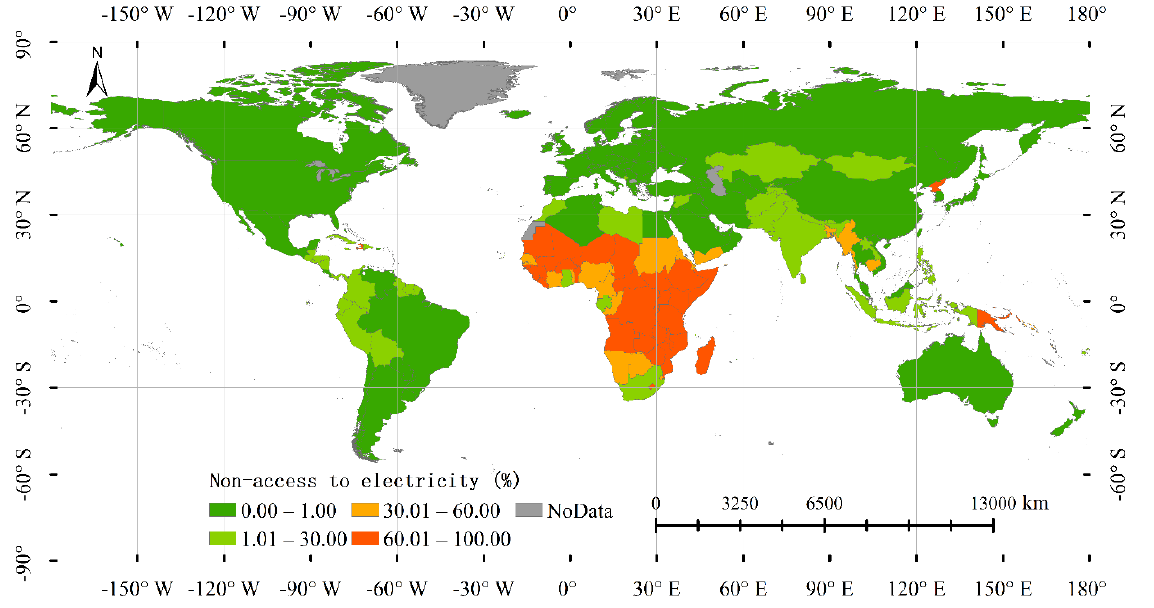
Figure 6. Spatial distribution of non-access to electricity data by country,